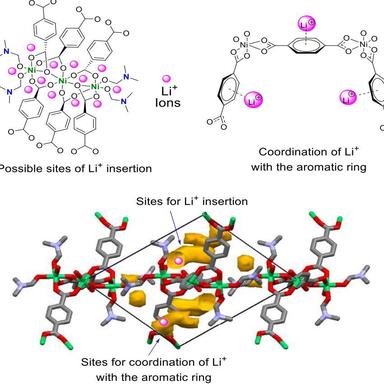
Sites of insertion and coordination of Li+ with aromatic rings in the structure.